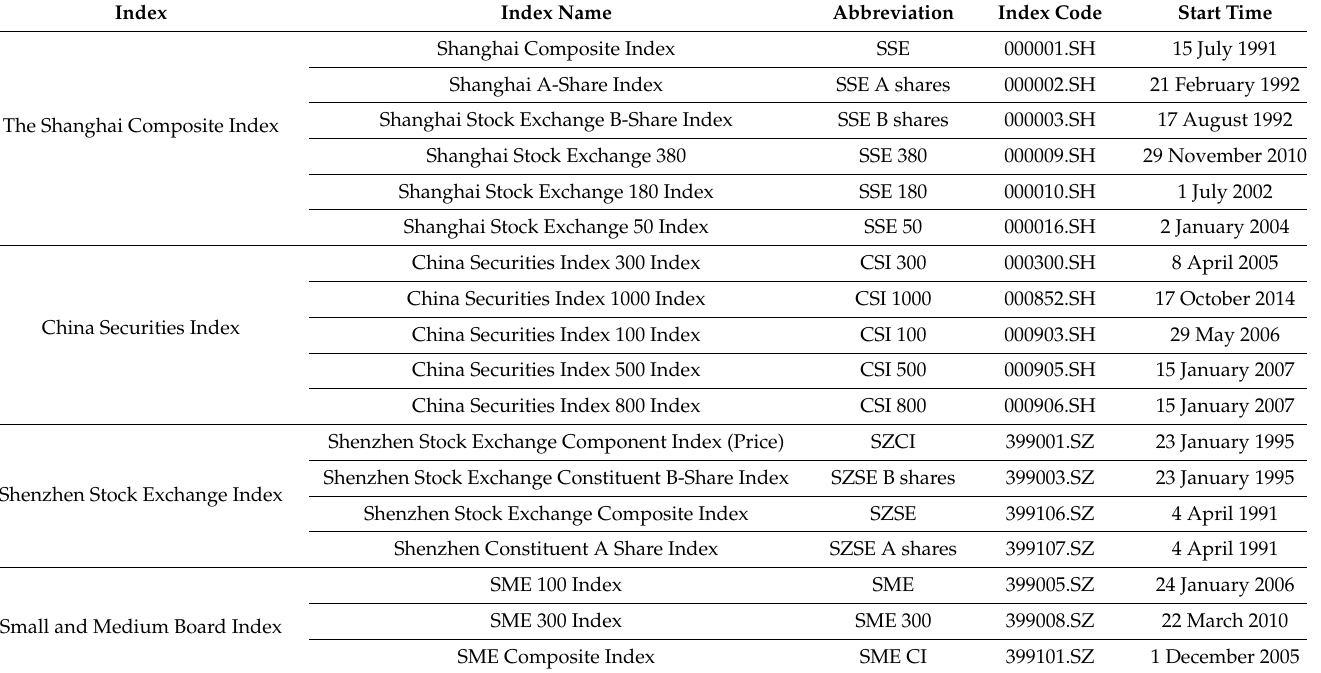
Table 1. The name and code of the selected stock